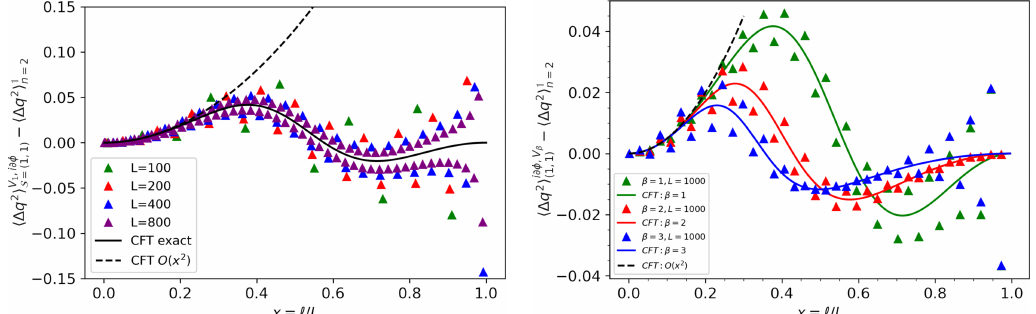
Figure 7 . Left: the CFT prediction of the excess of variance function of x is plotted against the numerical data for the XX chain for different system sizes ( L = 100 , 200 , 400 , 800 ). Right: (cid:10) ∆ q 2 (cid:11) V β ,i∂φ as a function of x = ‘/L . Numerical data refer to the low energy excitations of the half-filled XX chain for L = 1000 . As known from OPE arguments, the excess of variance at order O ( x 2 ) does not depend on β , but this is no longer true for larger x